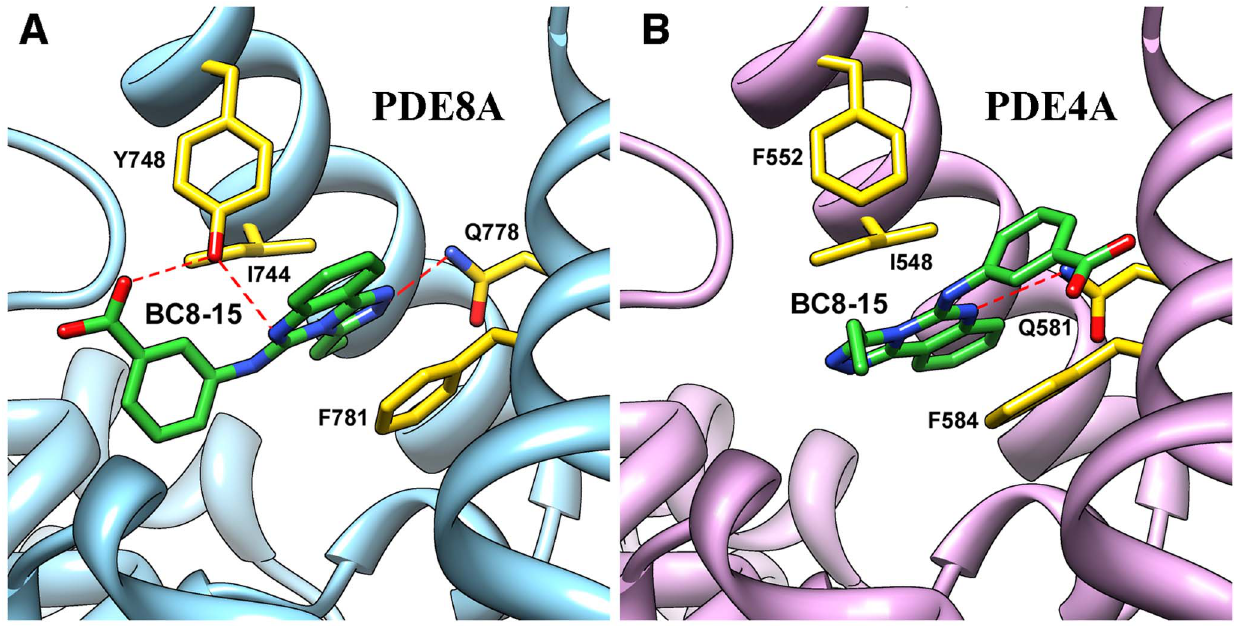
Figure 6. Docking simulation of BC8-15 with PDE8 and PDE4. The binding of BC8-15 with lowest energy was searched by the AutoDock4 software and visualized by UCSF Chimera 26 . A) Proposed binding orientation of BC8-15 in PDE8A (PDB ID: 3ECN) suggests three hydrogen bonding interactions (shown with dashed lines) through Y748 and Q778. B) BC8-15 adopts a different binding orientation with PDE4A (PDB ID: 2QYK) that favors mostly hydrophobic